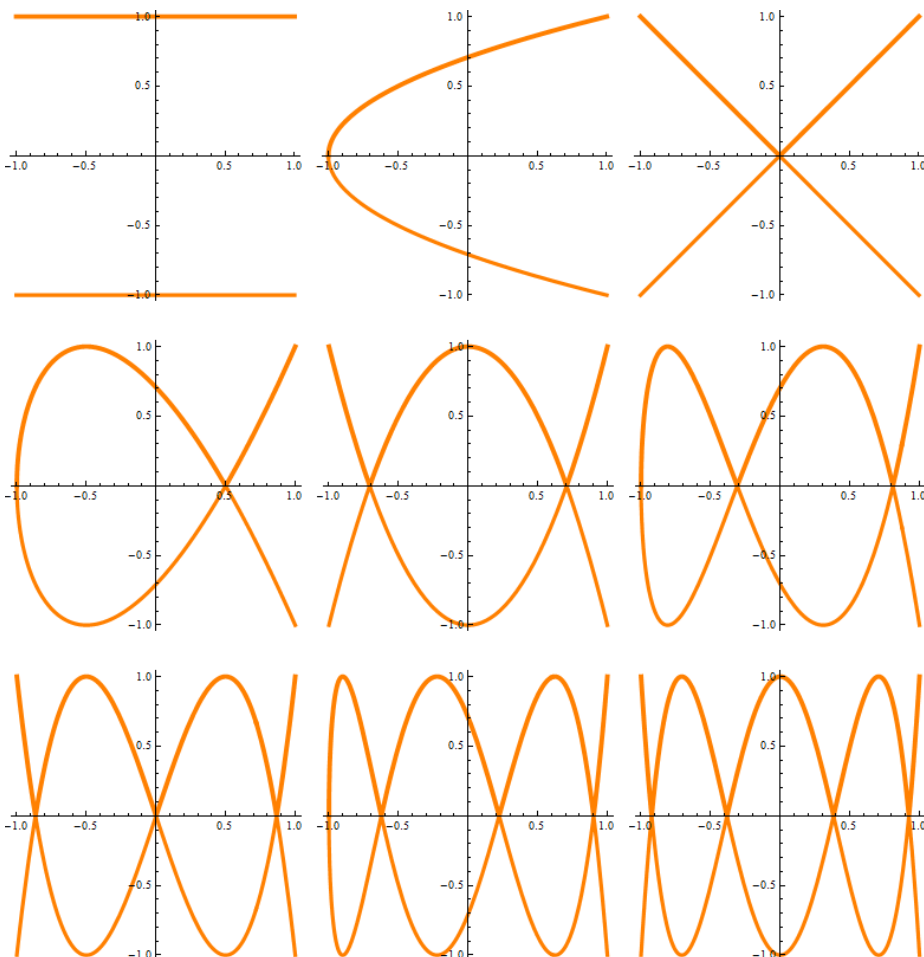
Figure 3. The first 9 white